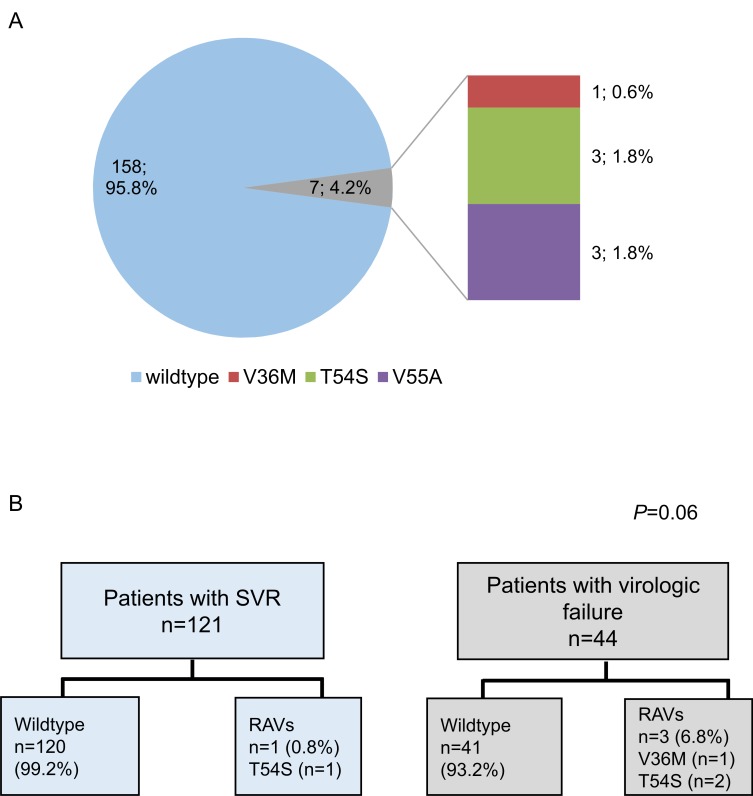
A) Prevalence BOC/TVR-relevant NS3 RAVs at baseline. B) Prevalence of RAVs in patients with SVR versus virologic failure (without V55A variant, see text).